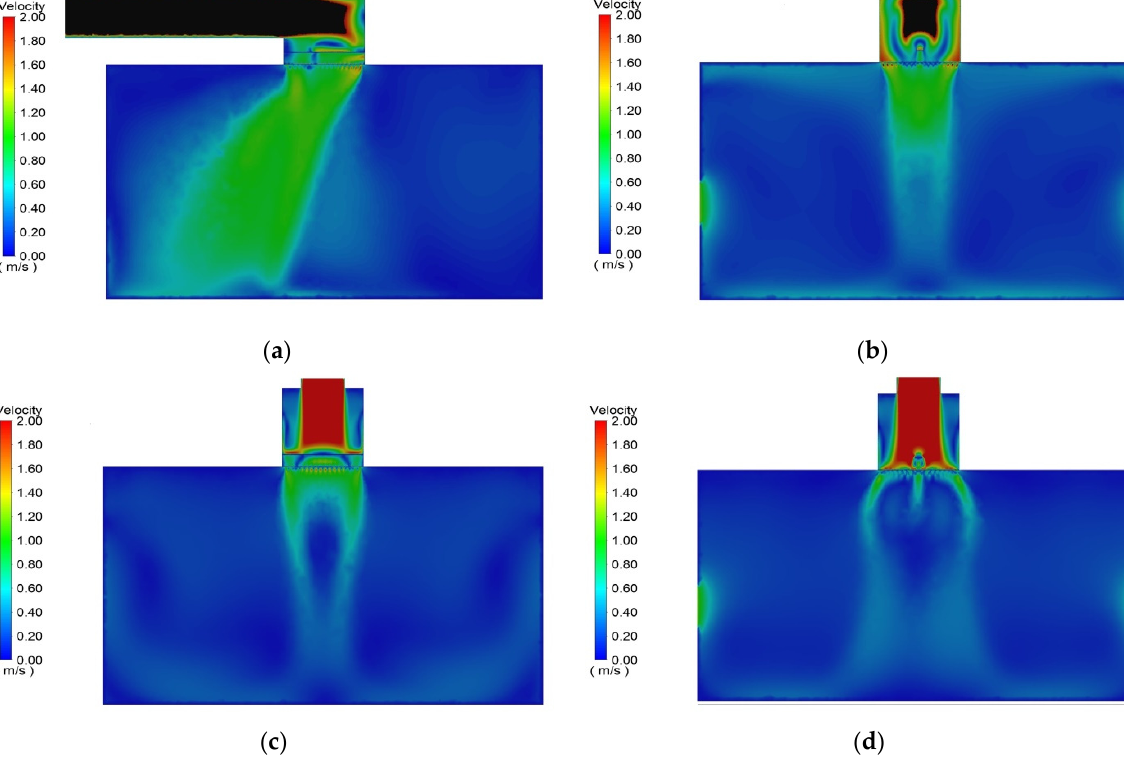
Figure 16. Velocity magnitude distribution in the plane passing through the center of the spigot of the plenum box with ( a ) side entry, Z-Y plane, X = 0 mm; ( b ) side entry, X-Y plane, Z = 0 mm; ( c ) top entry, Z-Y plane, X = 0 mm; and ( d ) top entry, X-Y plane, Z = 0 mm.